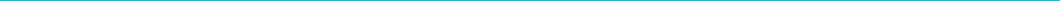
Figure 1: Bone fracture complications due to neurofibromatosis. (A) Radiograph of a 12- year-old boy’s ulna after a minor trauma, with signs of a chronic non-union and deficient bone healing. Further investigation led to the diagnosis of neurofibromatosis type 1, which includes bone mineralisation abnormalities. (B) A long fibular graft including the growth plate was harvested to ensure safe reconstruction and preservation of balanced forearm growth. (C) The postoperative assessment indicates consolidation of the proximal ulna and an open epiphysis, although the positive result was achieved at the cost of extensive morbidity at the site of the